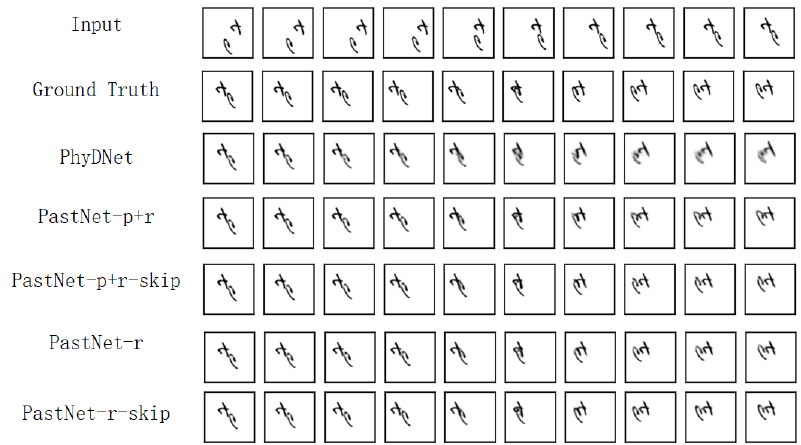
Figure 4. Output examples of models evaluated on Moving